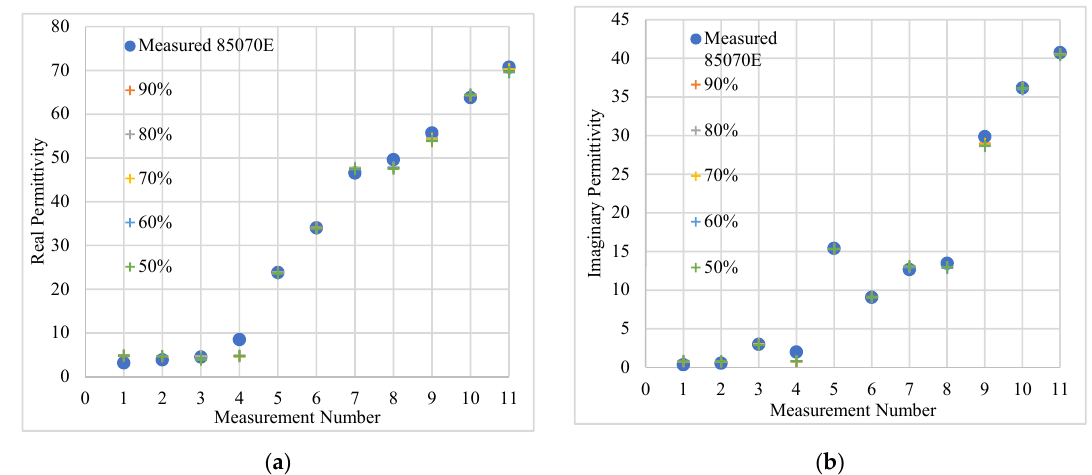
Figure 10. The computed and measured real ( a ) and imaginary part ( b ) of the complex permittivity for all testing data (eleven samples) at 2.45 GHz. The computed data was obtained by varying the ratio between the validation and training data. The percentages refer to the fraction of the data set used for training, the remainder being used for validation. The measured data was obtained using the Slim Form probe calibrated at reference plane A (probe tip) while the ANN input data was obtained with the calibration plane at the VNA test port (reference plane B in Figure 1).